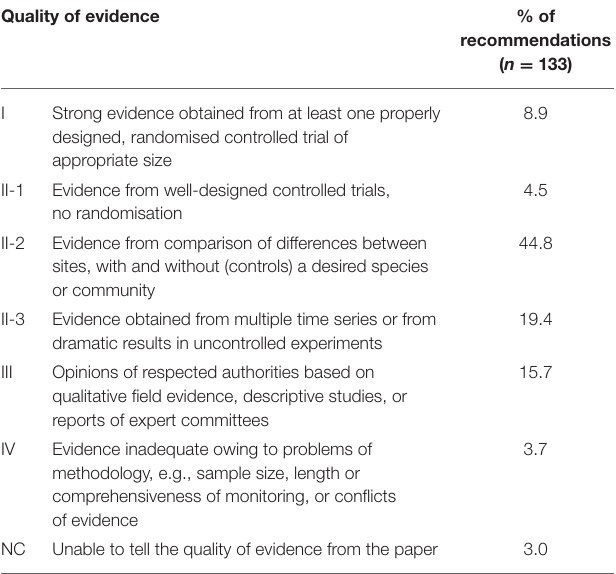
TABLE 3 | The quality of evidence for the 133 evidence-based recommendations from the 64 publications that provided recommendations for interventions (Salafsky et al.,